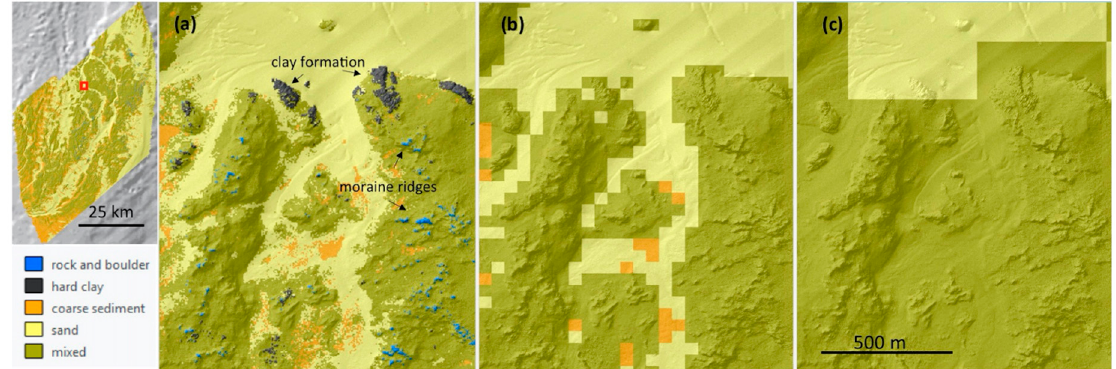
Figure 13. Comparison of HUB 3 substrate maps created using different scales; as the analysis window grows smaller features quickly give way to more general classes such as mixed sediments. ( a ) 5-m resolution, ( b ) 50-m resolution, ( c ) 250-m